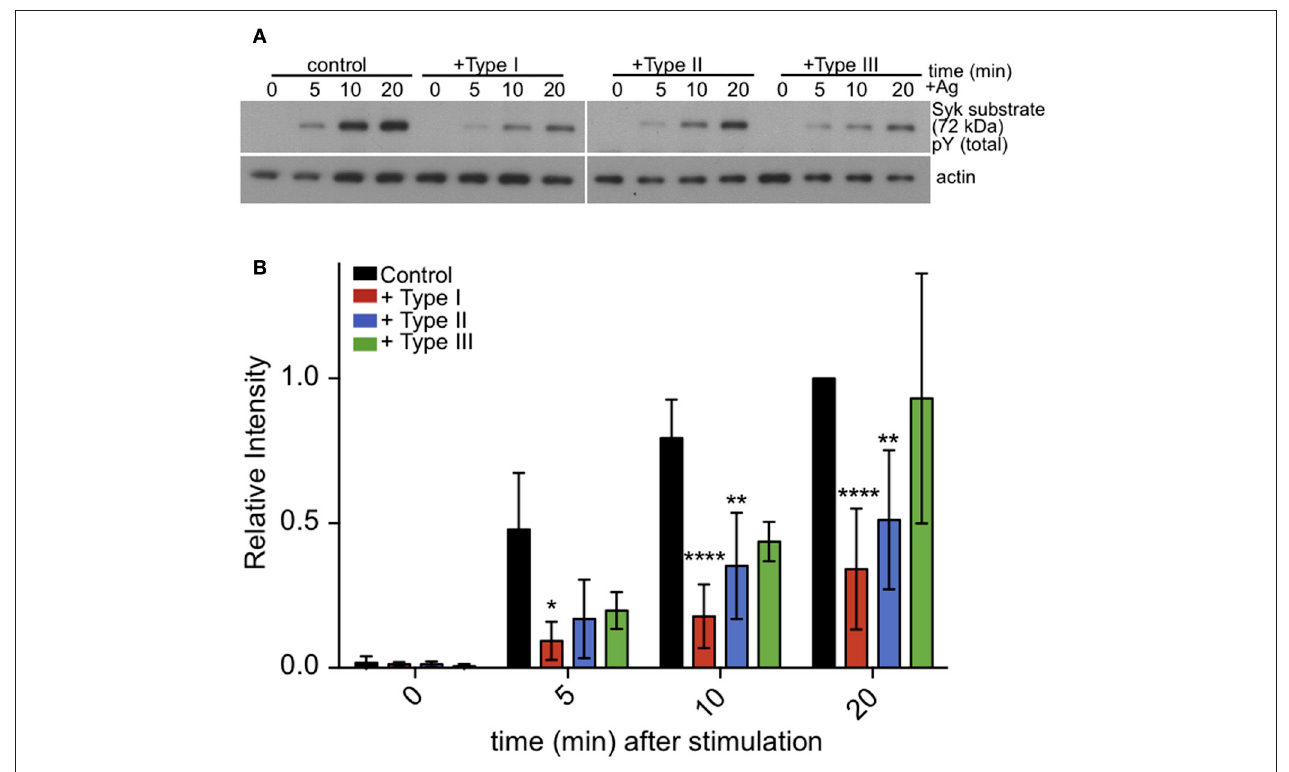
FIGURE 6 | Tyrosine phosphorylation of pp72 Syk substrate is reduced in T. gondii infected cells. IgE-sensitized RBL cells were infected for 1h with Type I, II or III tachyzoites as indicated. Antigen-stimulated cells were lysed at 0, 5, or 10min after addition of multivalent antigen (10ng/ml DNP-BSA). (A) Representative blot: